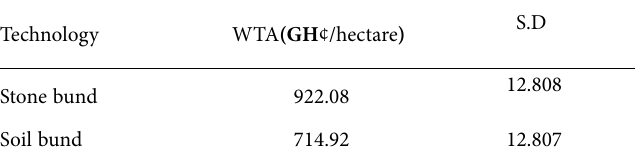
Table 5. Interval data model estimates on farmers’ WTA for stone bund and soil